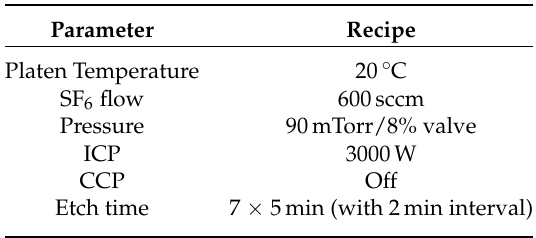
Table 1. Settings of the isotropic reactive ion etching (RIE) release etch recipe on the SPTS Pegasus and Oxford Instruments PlasmaPro 100